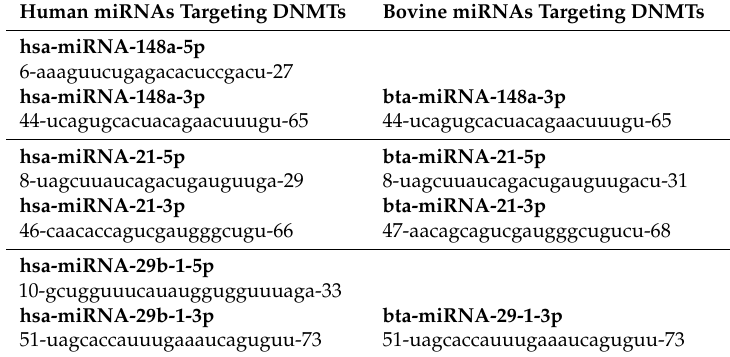
Table 2. High complementarity of seed sequences between human and bovine DNMT-targeting